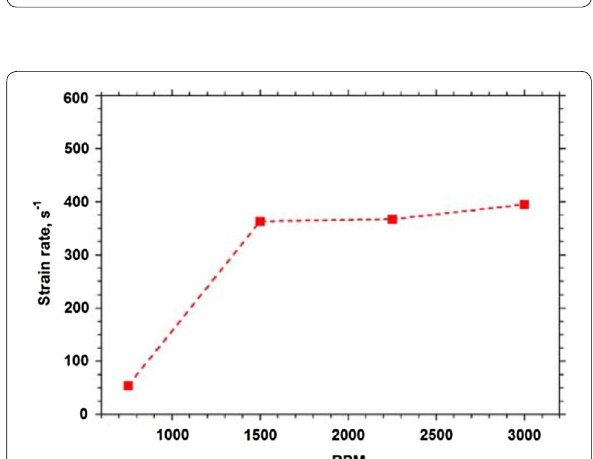
Figure 22 Strain distribution across the workpiece cross-section rotational speed of 1000 and 60 mm/s [116]